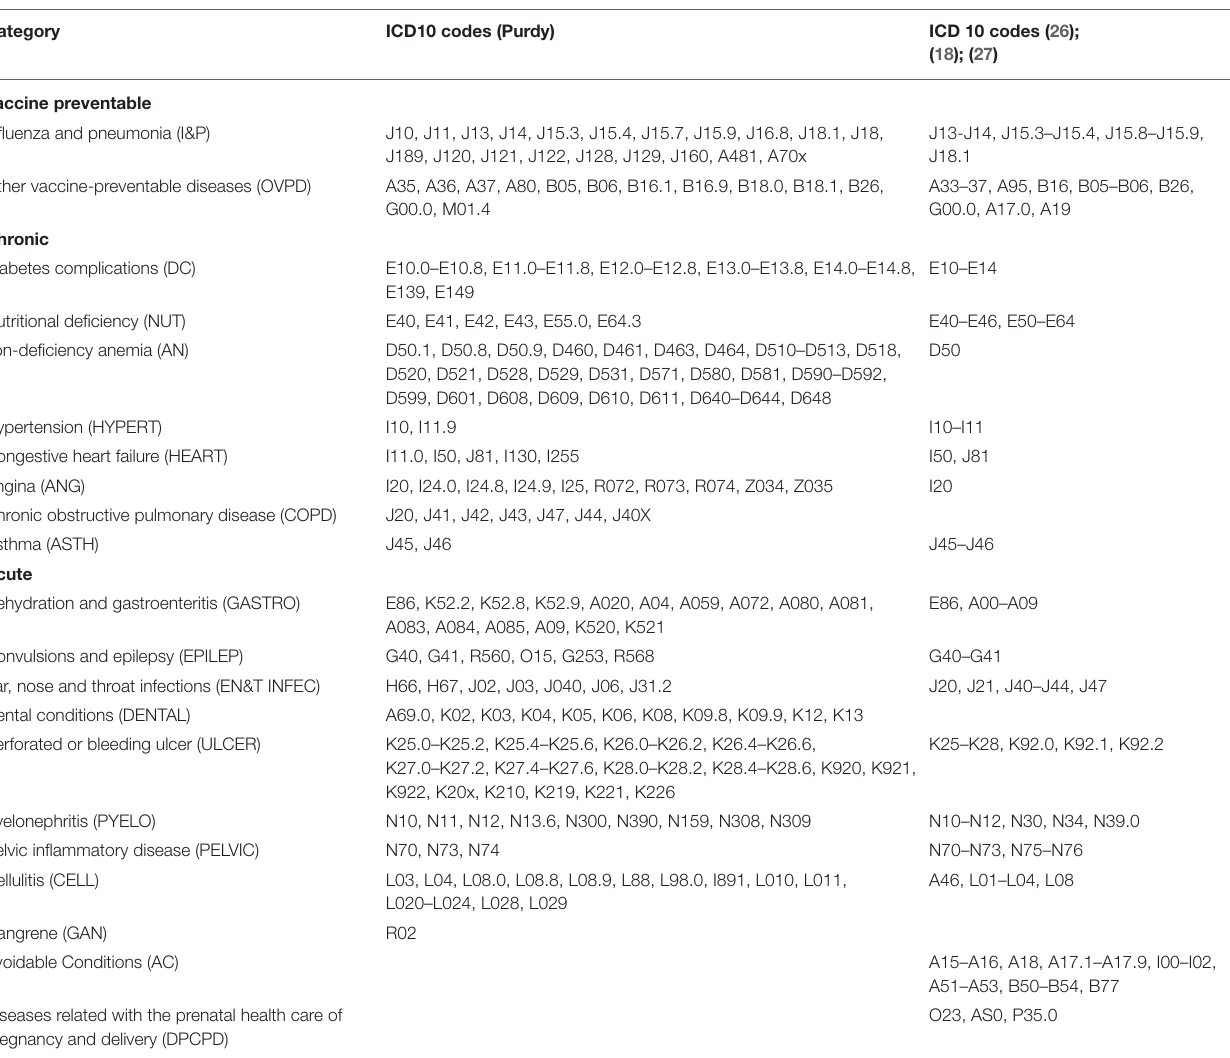
TABLE 1 | ACSC categories, ICD 10